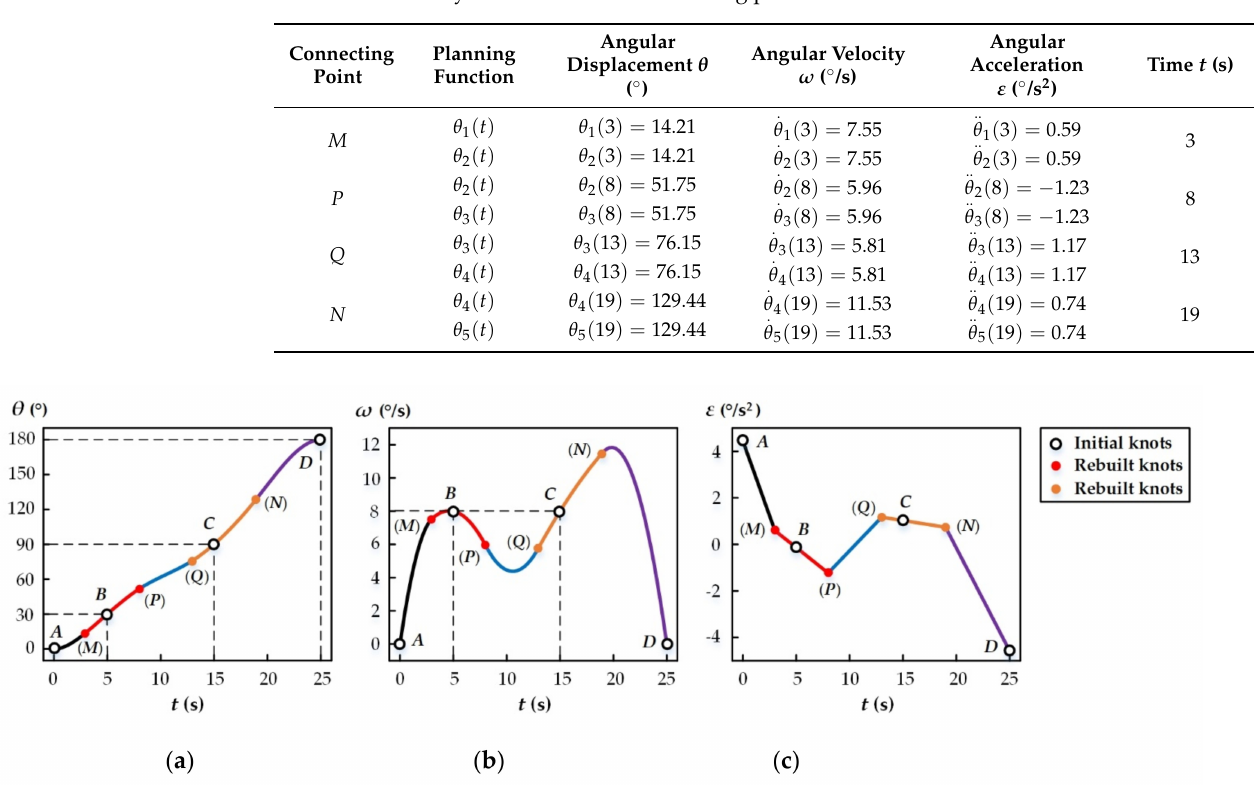
Table 4. Continuity validation at the connecting points.